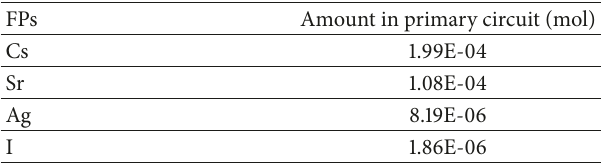
Table 9: Accumulation of Cs/Sr/Ag/I in the primary circuit 23 h after beginning of the accident.